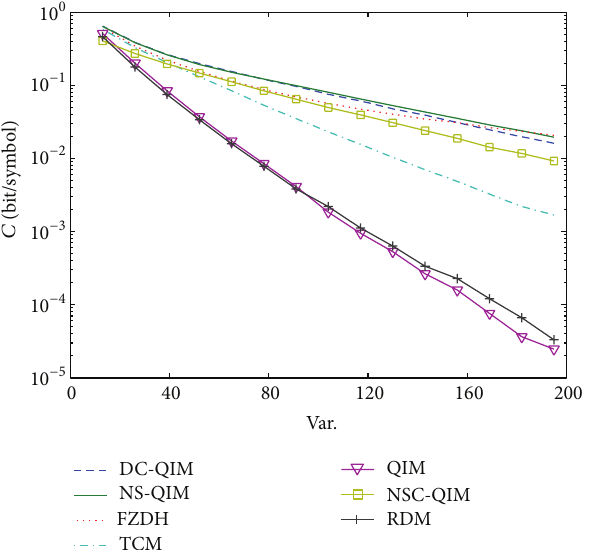
Figure 5: Capacity under JPEG for natural grayscale